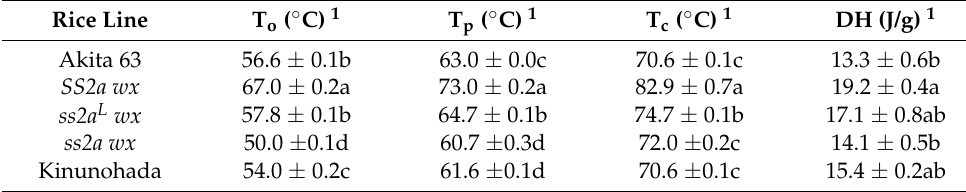
Table 3. Gelatinization temperature of purified endosperm starch determined by